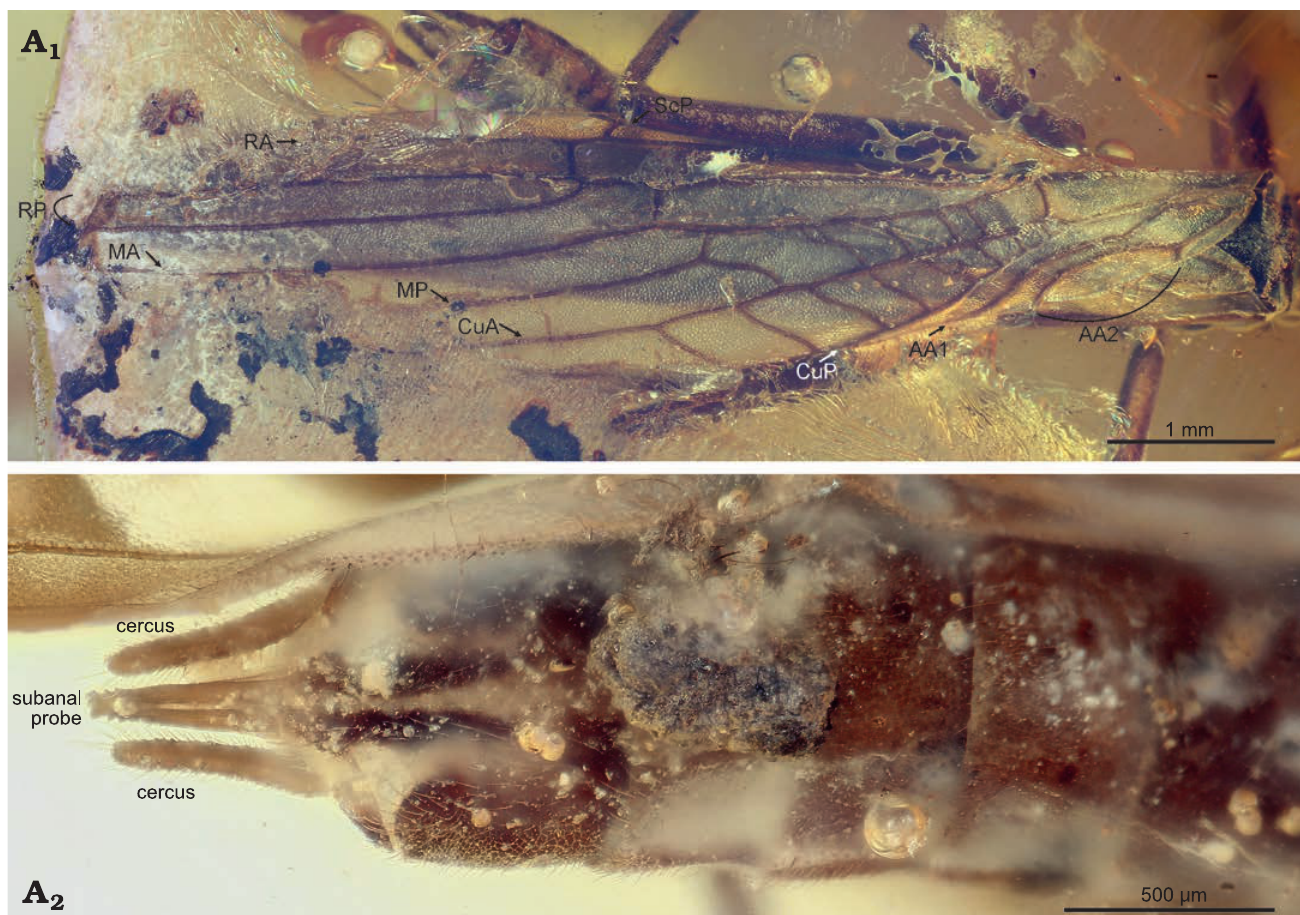
Fig. 5. Needle stonefly Euroleuctra gillesi Chen, 2018b (ICJUST CZT-PLE-BA3) from Eocene Baltic Amber from unknown locality in Poland. Male adult, photomicrographs of left forewing in dorsal view (A